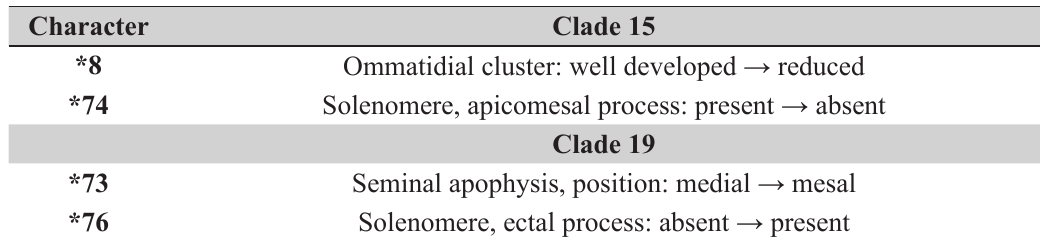
Table 4. List of characters recovered to support the clade 15 and 16 from the cladistic analysis (see Fig. 4). Only discrete characters are shown. Characters marked with an asterisk (*) are homoplastic synapomorphies.